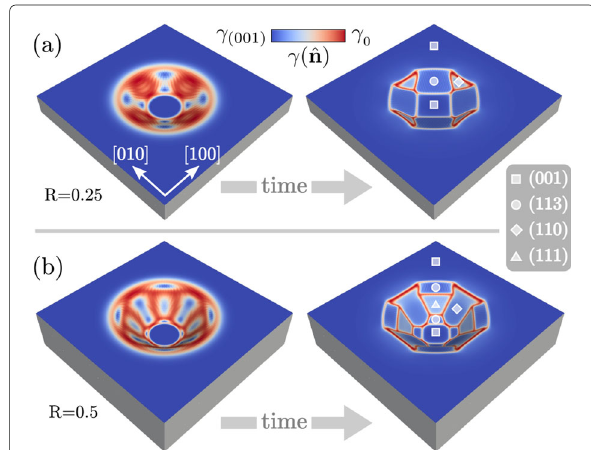
Fig.2 Facetingoftheinitialprofileasdefinedinthe“InitialMorphology and Simulation Setup” section according to surface diffusion and γ( ˆ n ) reproducing the surface energy of Si. Two different initial morphologies are considered: a R = 0.25 and b R = 0.5. On the faceted morphologies, symbols are adopted to identify the families of facets. The color scale shows the values of γ( ˆ n ) at the